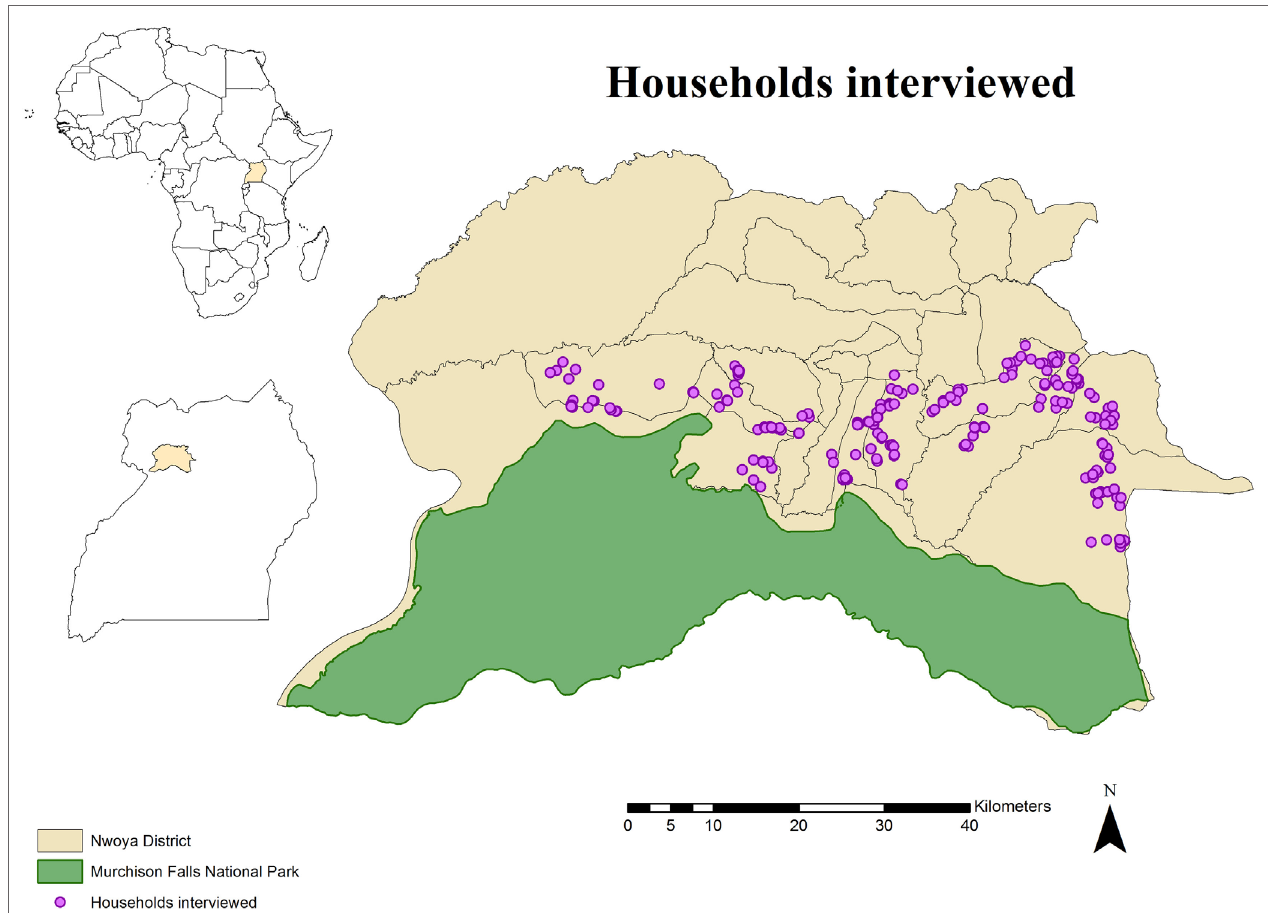
FigUre 1 | spatial distribution of 233 pig owning households individually interviewed in southern nwoya district, Uganda, near Murchison Falls national Park, 2015